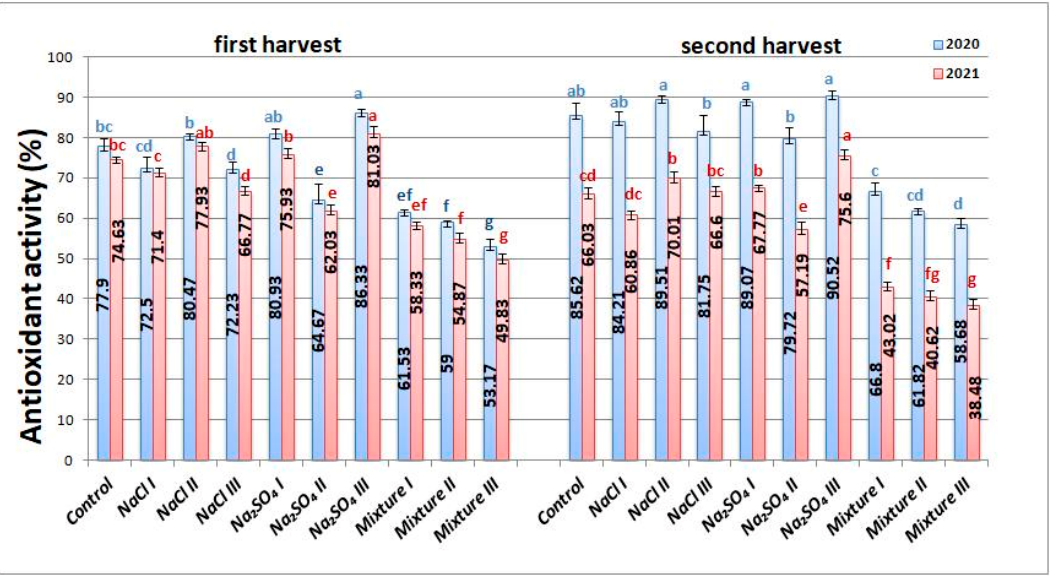
Figure 7. Antioxidant activity of Nepeta racemosa Lam. variants in 2020 and 2021, with significant differences at 0.05 level indicated with letters.